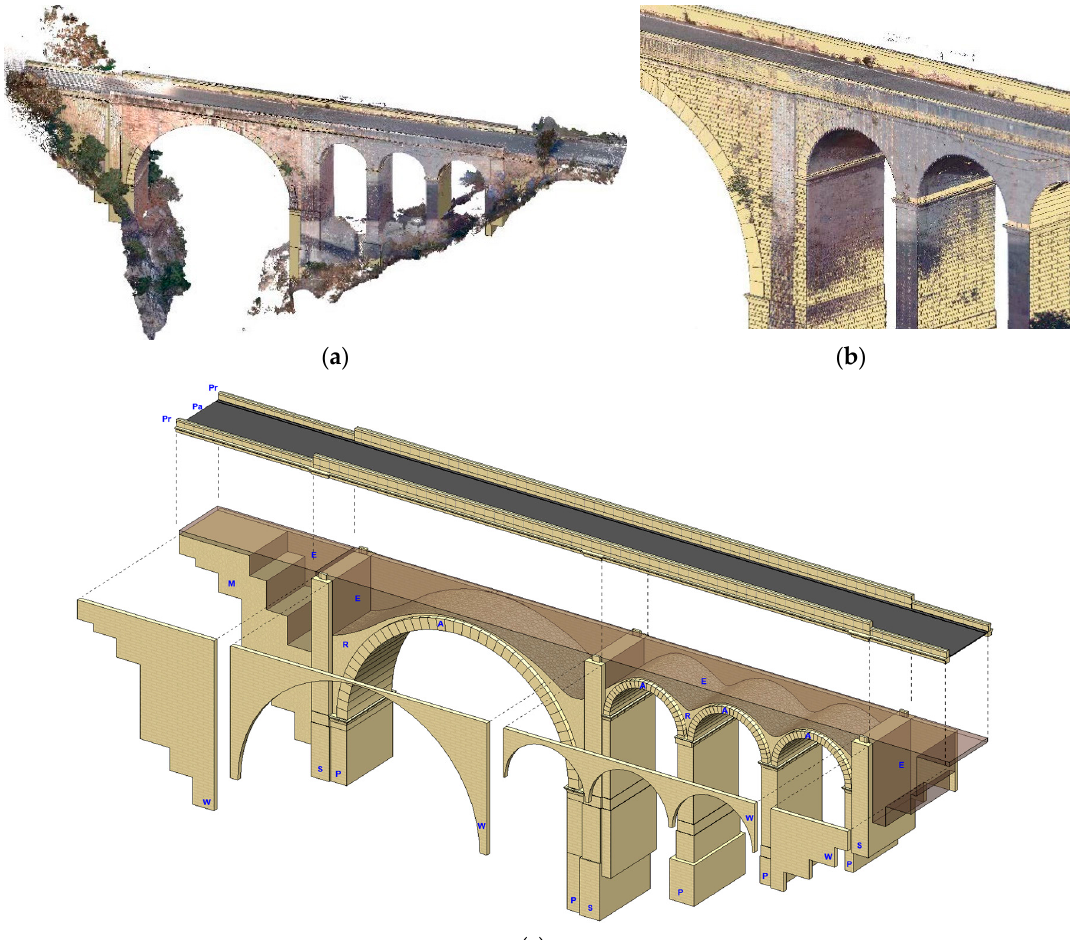
Figure 8. Í zbor bridge PC (Point Cloud) and the BIM (Building Information Modeling) model. ( a ) and ( b ) PC and modeling. ( c ) exploded view of Í zbor bridge BIM